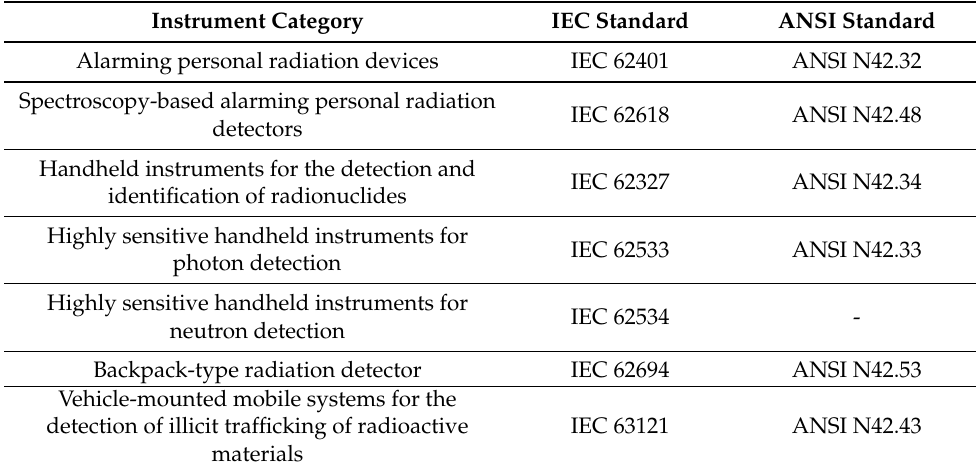
Table 1. Standards for mobile radiation detection equipment considering scenario B. Adapted from Reference